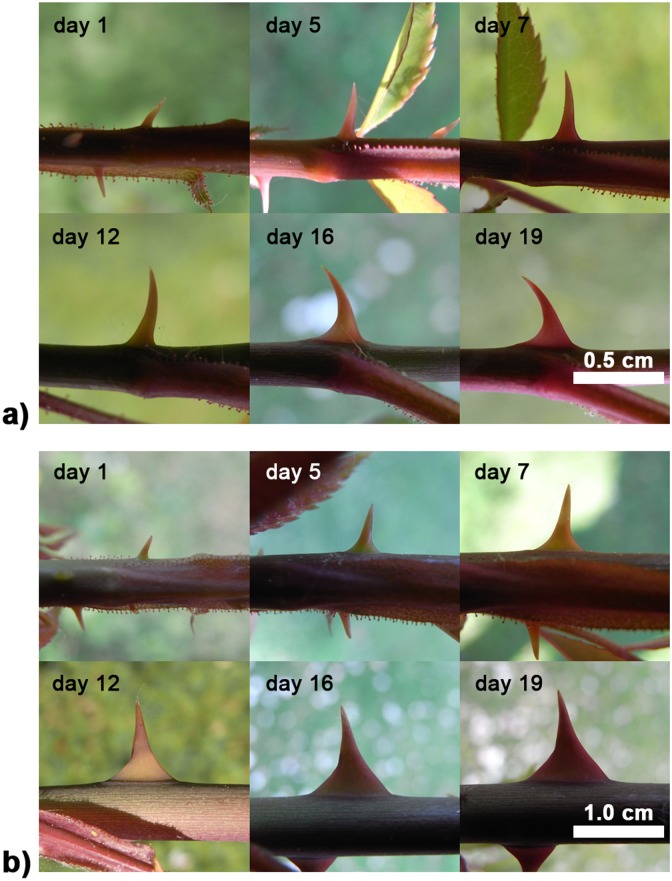
Development of prickles in the different types of long axes of Rosa arvensis ‘Splendens‘.a) type I, b) type II. In the younger stages (day 1–7) the glandular margins of adjacent leaf petioles lie flat against the axis (stem apex to the right).